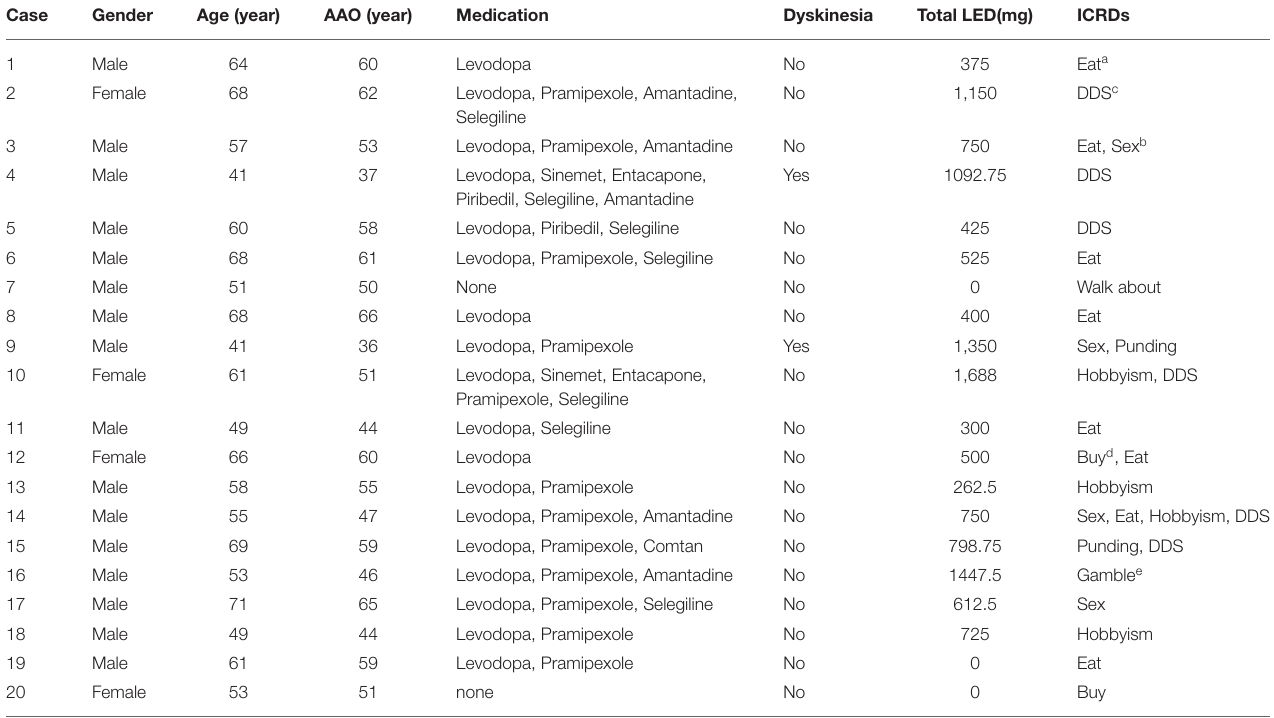
TABLE 1 | Demographic and clinical characteristics of 20 PD-ICRDs patients.